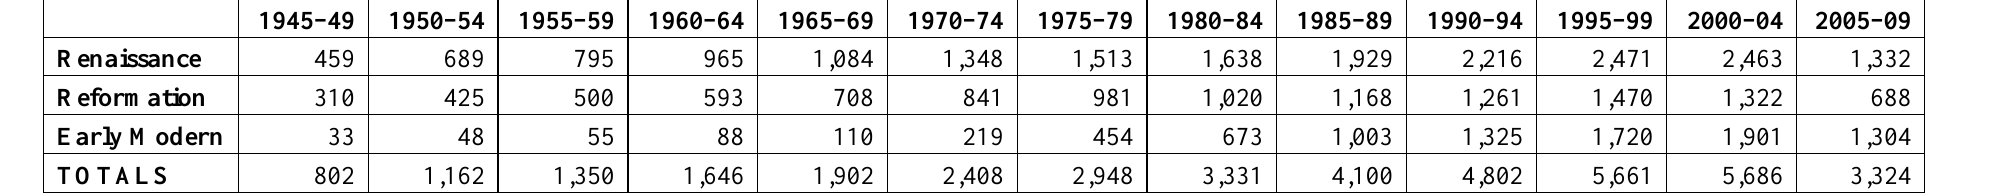
Table 1. Absolute Frequency of Renaissance, Reformation, and Early Modern in History Journals on JSTOR.